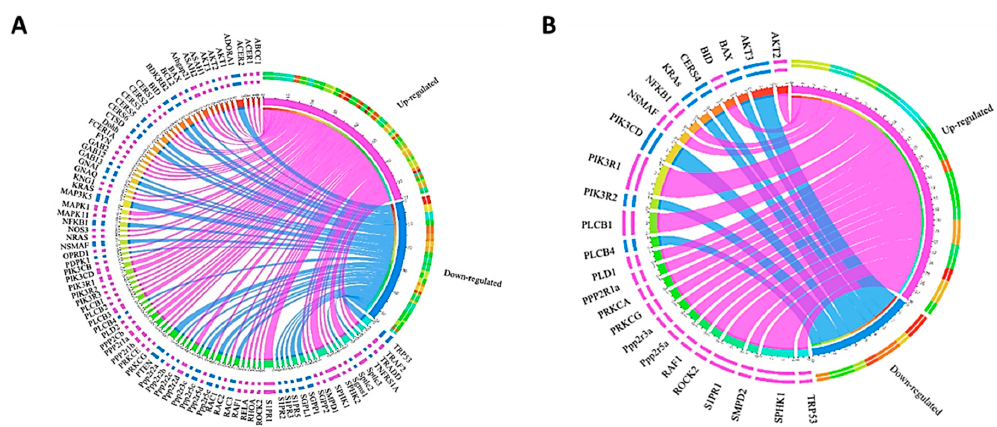
Figure 6. Chord diagrams showing genes with significantly different expressions ( p < 0.05) between differentiated and undifferentiated SGBS cells ( A ) and 3T3-L1 cells ( B ) upon 100 nM S1P treatment. di ff erentiated and undi ff erentiated SGBS cells ( A ) and 3T3-L1 cells ( B ) upon 100 nM S1P treatment. The up- and downregulated genes are shown in magenta and blue, respectively. The up- and downregulated genes are shown in magenta and blue,